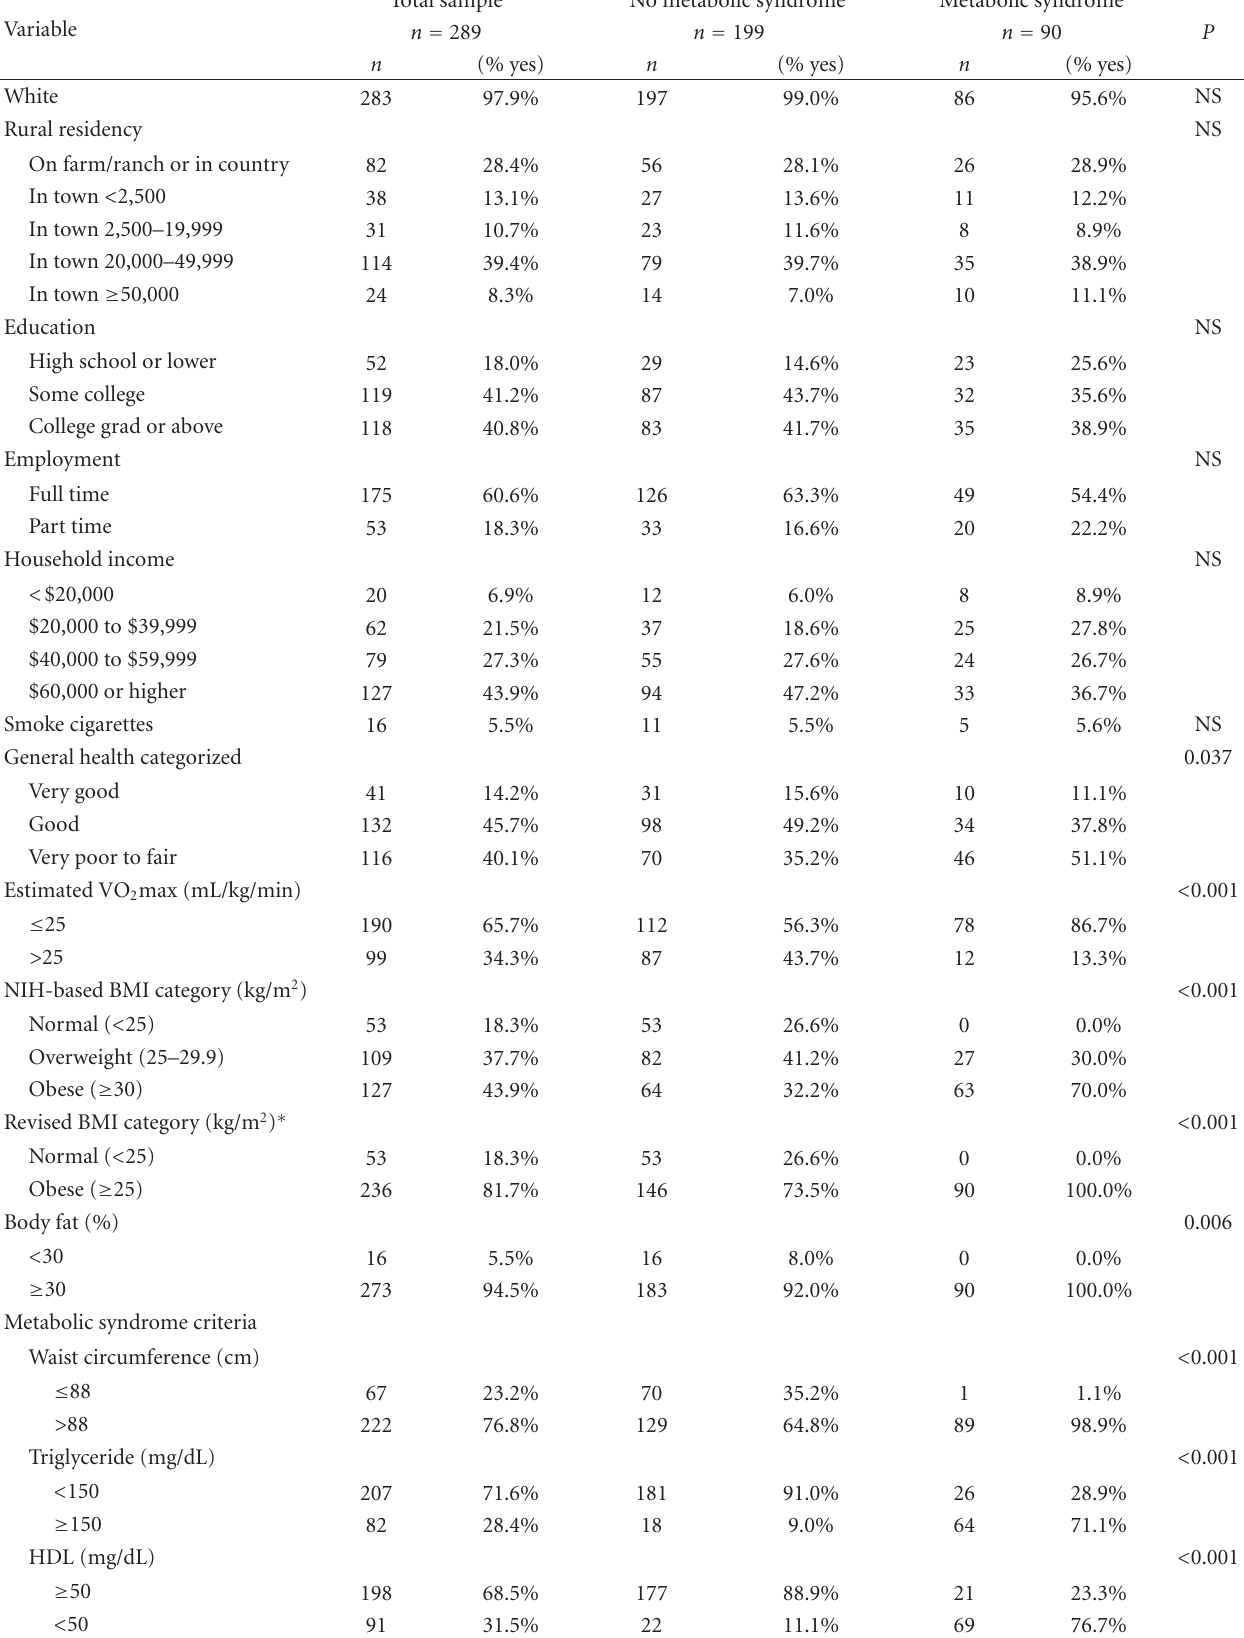
Table 1: Characteristics of rural women with prehypertension according to the presence of metabolic